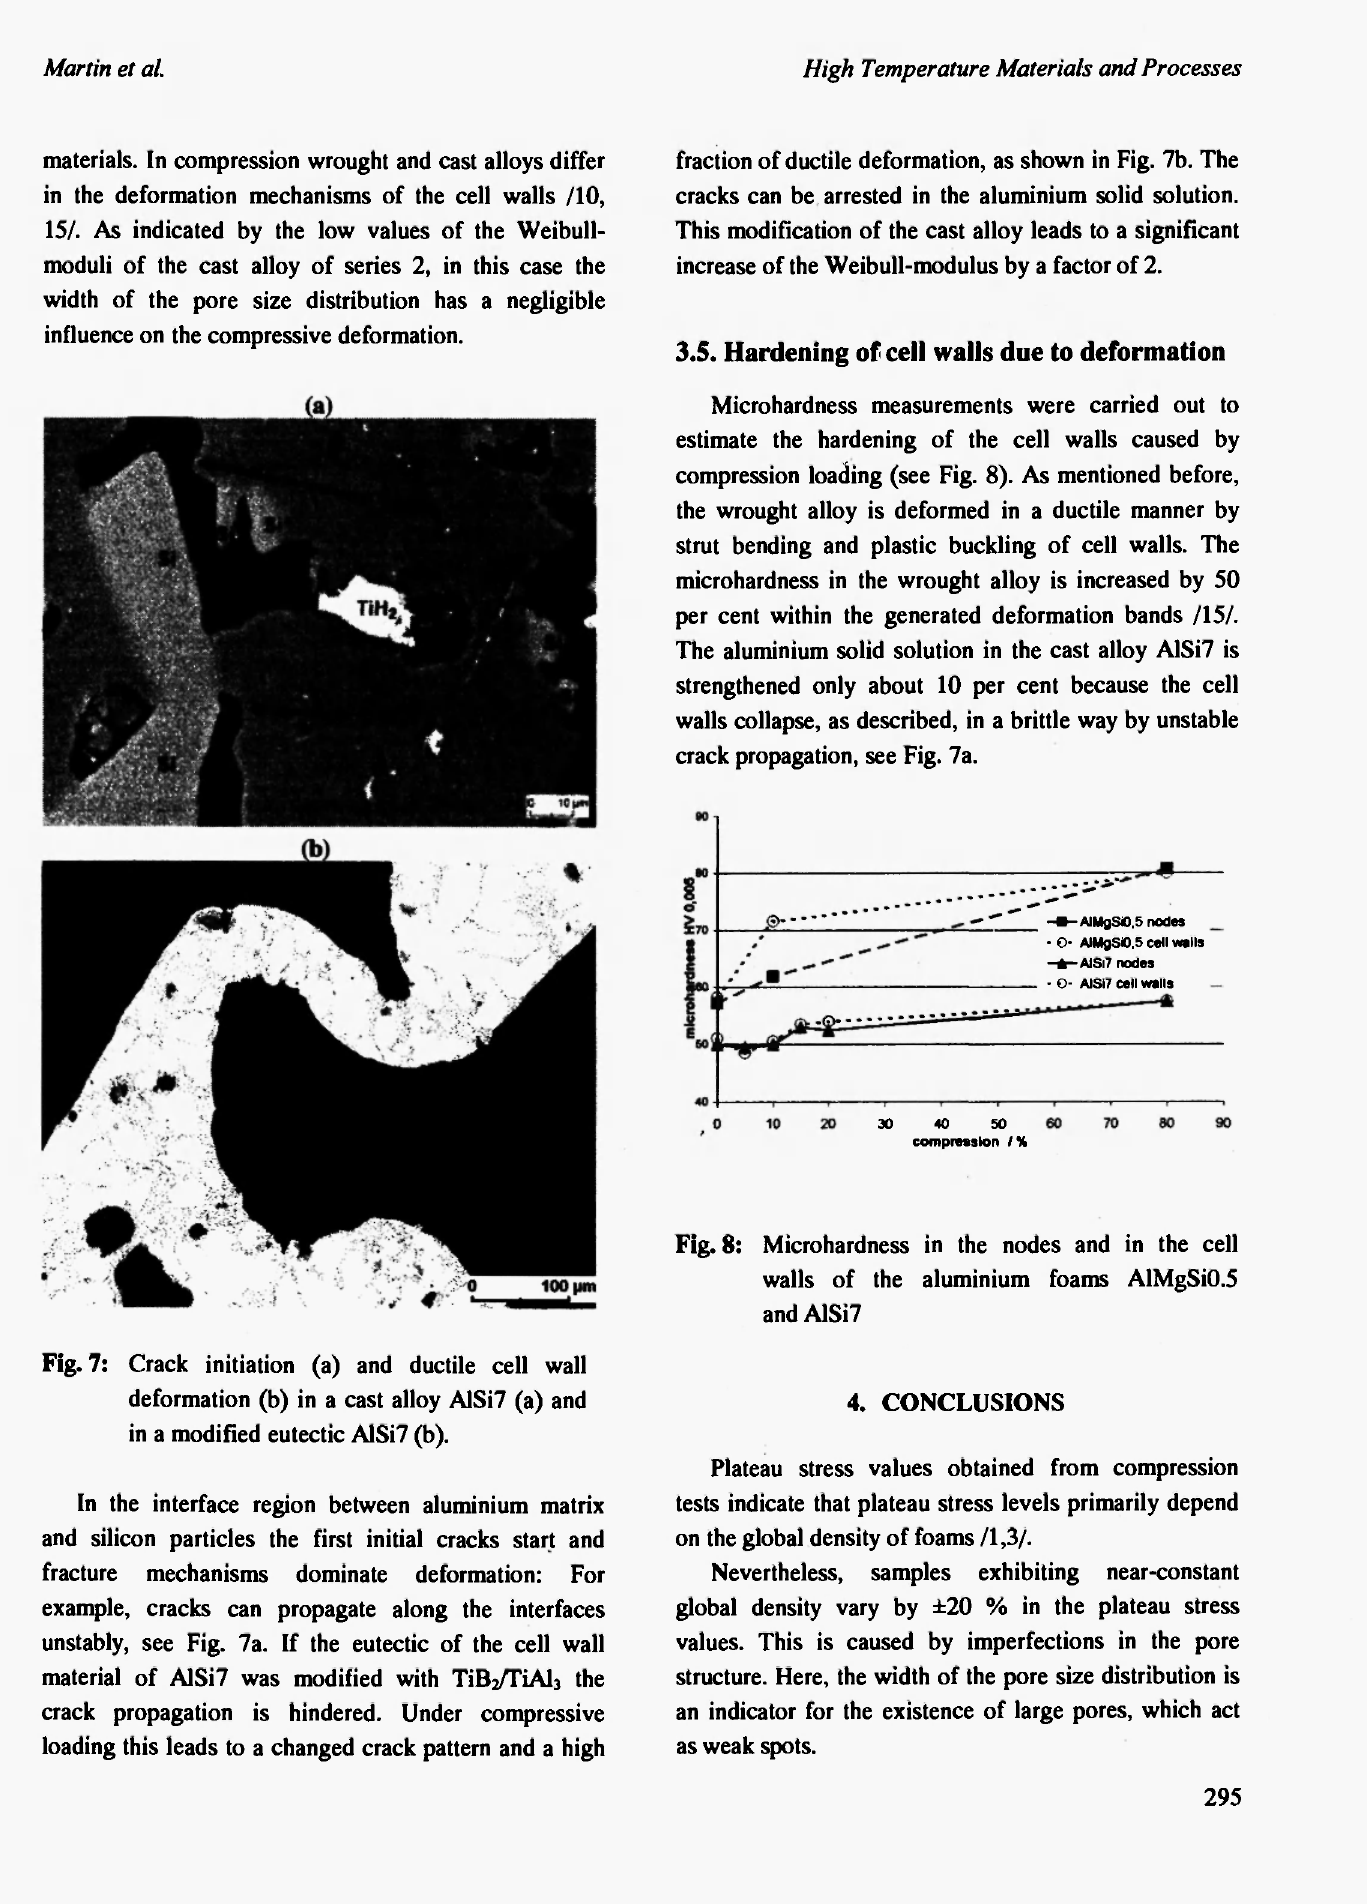
Fig. 8: Microhardness in the nodes and in the cell walls of the aluminium foams AlMgSiO.5 and